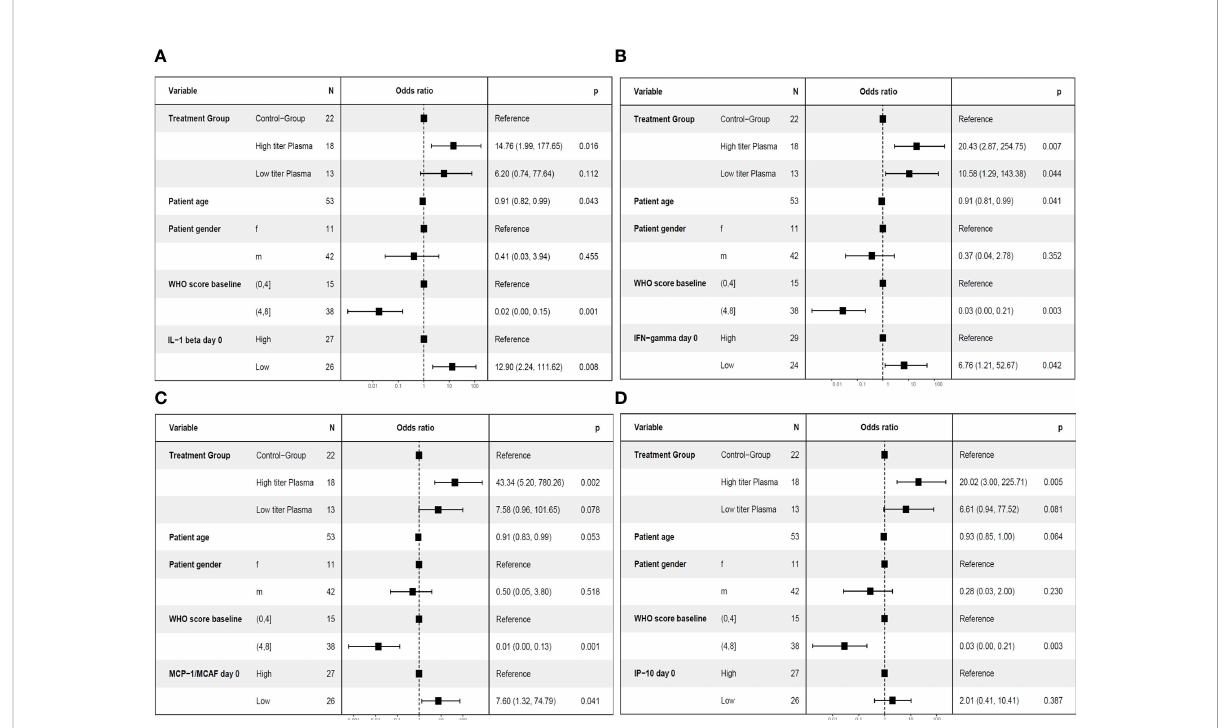
FIGURE 7 Multivariate analyses of primary endpoint (survival and no longer meeting criteria for severe COVID-19 on day 21) including cytokine levels on day 0. The following variable were included in the model: Treatment group (control group, high titer plasma, low titer plasma), age (as continuous variable), gender (female (f)) and male (m), baseline WHO Severity Score ( ≤ 4 vs. > 4) (11) and the level of the respective cytokine on day 0 ( ≤ median ( “ low ” ) versus > median ( “ high ” )). One cytokine each was included in the models: IL-1ß (A) , IFN- g (B) , MCP-1 (C) or IP-10 (D)